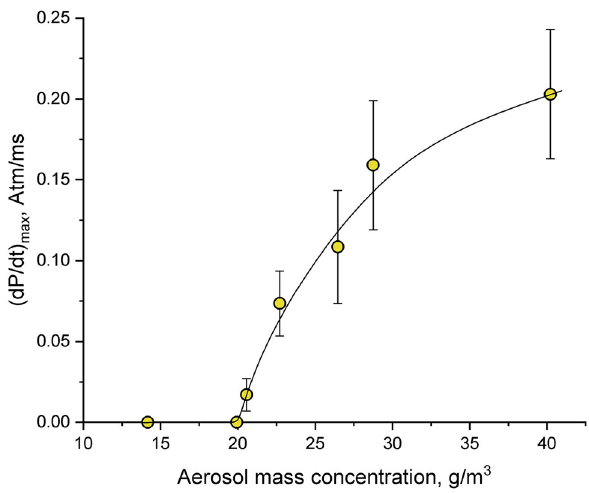
Fig. 14 d P/ d t max versus aerosol mass concentration in the reaction mixture. Methane concentration in the mixture is 3 molar%. Solid line is an eye guide